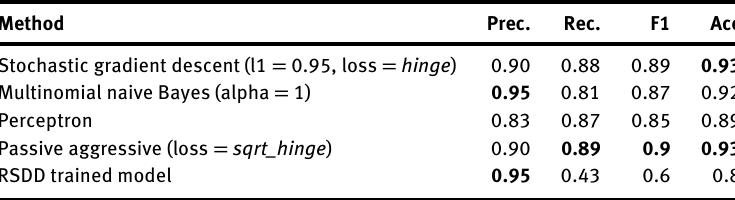
Table 6: Comparative results on classifying PPD. These results were obtained prior to the removal of depression related terms from the corpus.